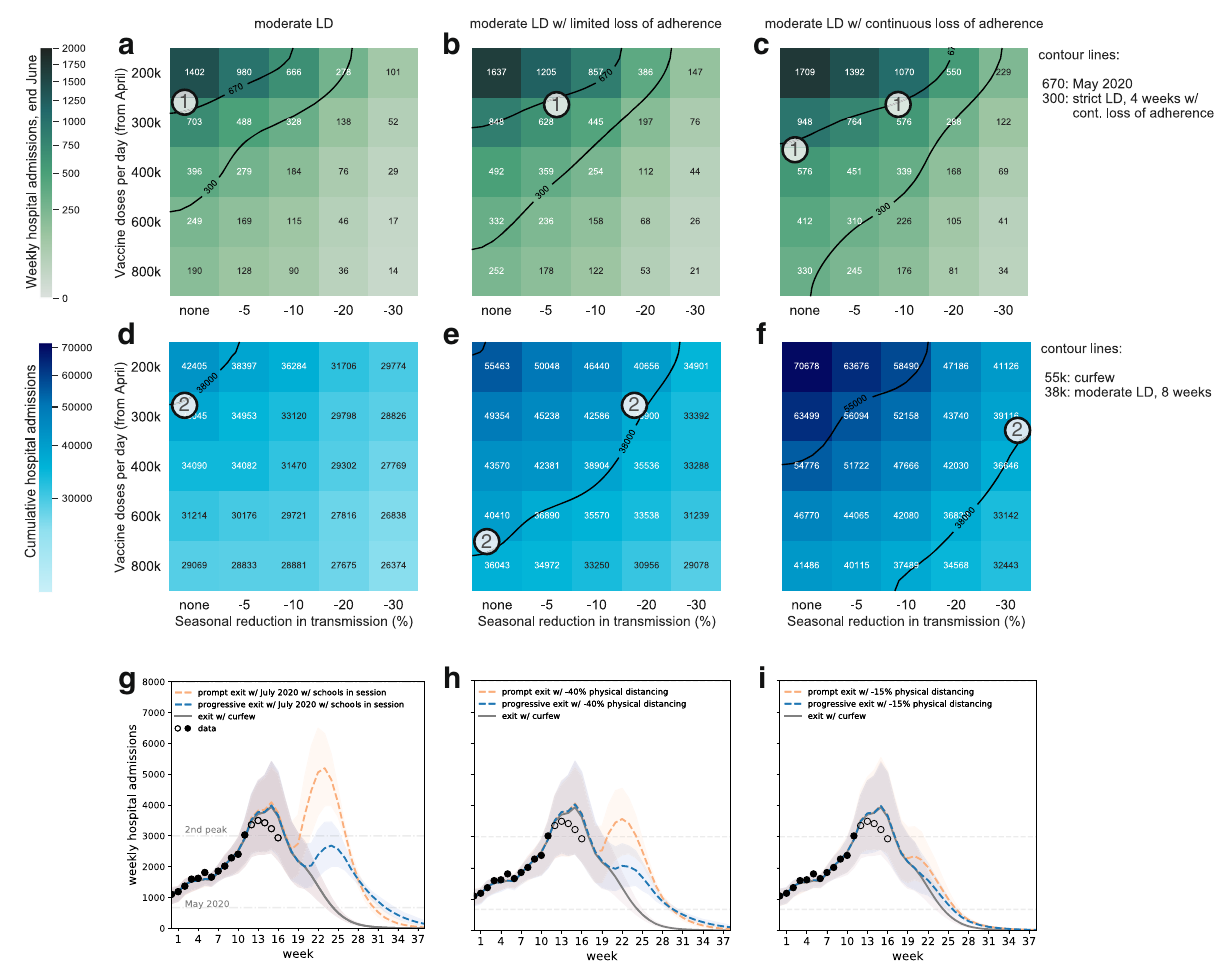
Fig. 5 Impact of vaccination, seasonality, and reopening plans. a – f Heatmaps show median values of weekly hospital admissions at the end of June (w26) ( a – c ) and cumulative hospital admissions in the time period w12 – w26 ( d – f ), as functions of vaccination rhythm ( y -axis) and seasonal reduction in transmission ( x -axis) for moderate lockdowns of 8 weeks with full adherence ( a , d ), limited loss of adherence ( b , e ), continuous loss of adherence ( c , f ). The abbreviation LD stands for lockdown, contour lines indicate reference values of speci fi c scenarios de fi ned in the legends. Circled numbers refer to a subset of conditions of interventions (heatmaps from left to right), vaccination and seasonality (variables in the y - and x -axis in each heatmap) achieving the same outcome, identi fi ed by the contour lines (see legend) and discussed in the main text. g – i Plots show projections of the weekly hospital admissions under different hypotheses for the reopening conditions, assumed right after lifting the moderate lockdown (orange curves), or through a progressive transition (blue curves): conditions experienced in mid-July 2020, but with schools in session ( g ); curfew scenarios with 40% fewer individuals respecting physical distancing ( h ); curfew scenarios with 15% fewer individuals respecting physical distancing ( i ). Curves and shaded areas correspond to median trajectories and 95% probability ranges, obtained from n = 250 independent stochastic runs. In all plots, gray continuous line refers to a scenario in which curfew conditions as in week 11 are restored after the moderate lockdown. Dots refer to data; fi lled dots correspond to the data used to fi t the model and to provide the trajectory for the curfew scenario; void dots correspond to data outside the inference time window showing the peak of the third wave. Scenarios assume a 10% reduction in transmissibility due to seasonality (except for the mid-July 2020 conditions that already embed seasonal aspects) and a vaccination rhythm of 300,000 fi rst doses per day starting April. Plots showing projections for the reopening conditions, assumed right after lifting the strict lockdown are shown in Supplementary Fig.